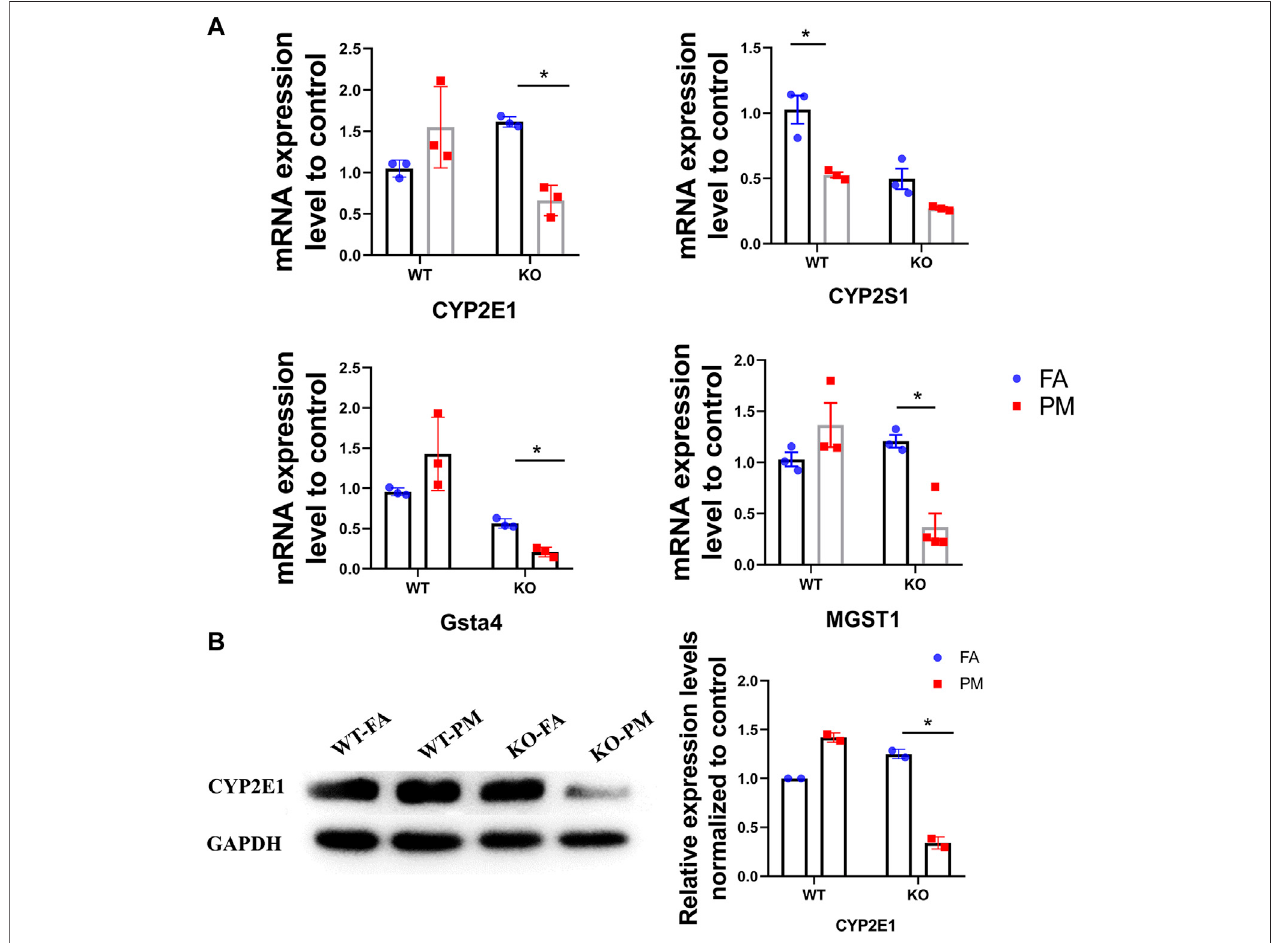
FIGURE 4 | Expression of CYP450 pathway related genes in four groups of mice. (A) The expression of main genes in the “ Metabolism of xenobiotics by cytochrome P450 ” pathway. n (cid:2) 3 per group. (B) The CYP2E1 protein expression levels in four groups of mice were analyzed by Western blot and the quanti fi cation of the CYP2E1 expression. n (cid:2) 2 per